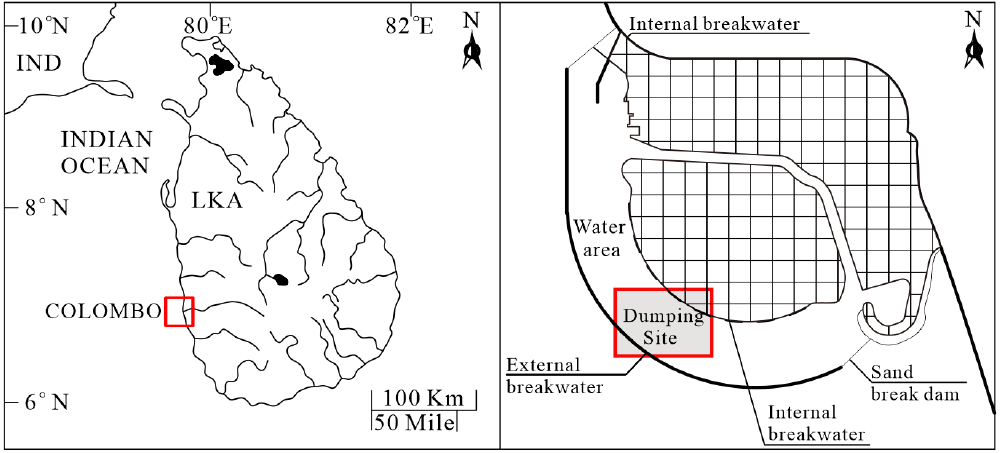
Figure 1. The study area and the sediment dumping site.